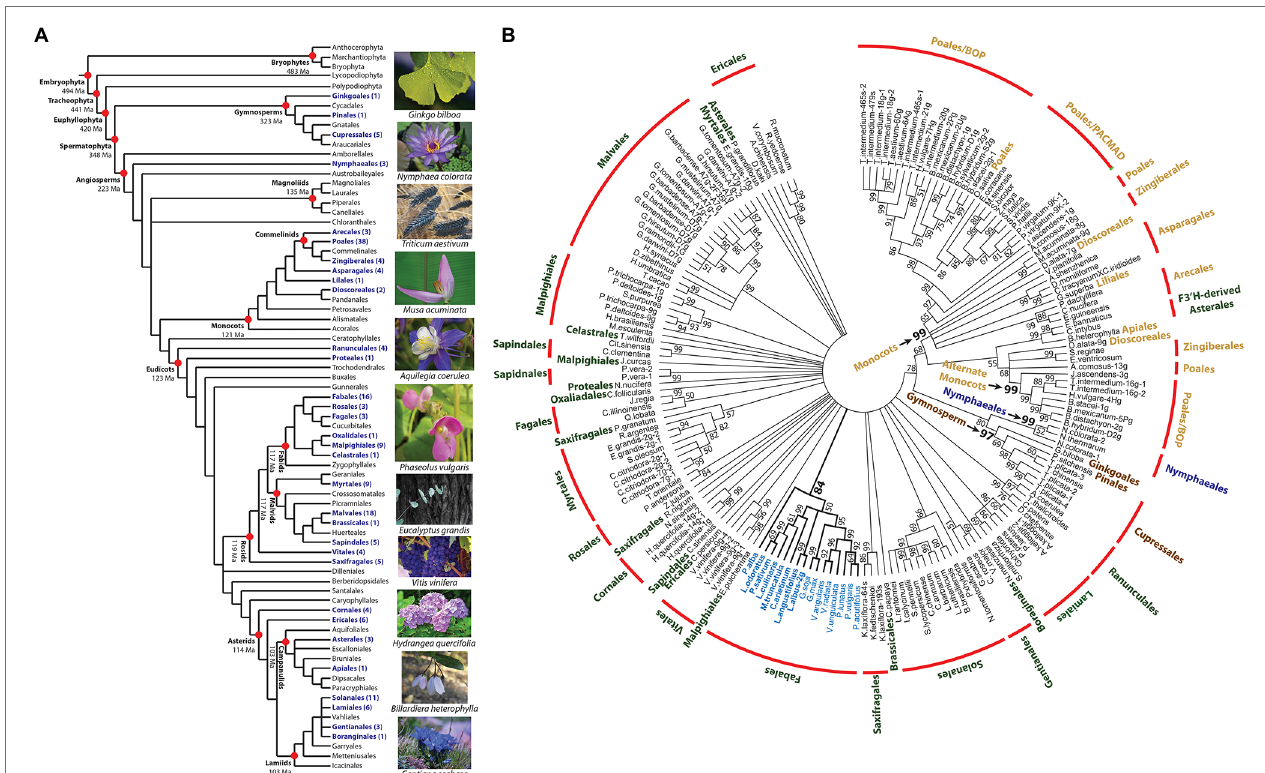
FIGURE 5 | Phylogenetic distribution and sequence relationships for land plant flavonoid 3 ′ 5 ′ hydroxylase proteins. (A) Distribution of F3 ′ 5 ′ H proteins among land plants higher order taxa. The tree was assembled by augmenting the 2016 angiosperm phylogeny (APG IV, 2016) with the evolutionary dating data in Morris et al. (2018), and gymnosperm ordering in Forest et al. (2018). The dating of the orders in the eudicots was based on Magallón et al. (2015). All other datings were based on the results (mean of range) for the monophyletic model presented in Table 3 of Morris et al. (2018). All taxa containing a species with a F3 ′ 5 ′ H protein sequence are noted in purple. (B) Unrooted 50-percent consensus maximum likelihood tree of land plant F3 ′ 5 ′ H protein sequences. The colors for each order are: water lily = blue; gymnosperms = brown; monocot = tan; and eudicot = green. Those nodes with bootstrap values >50% are